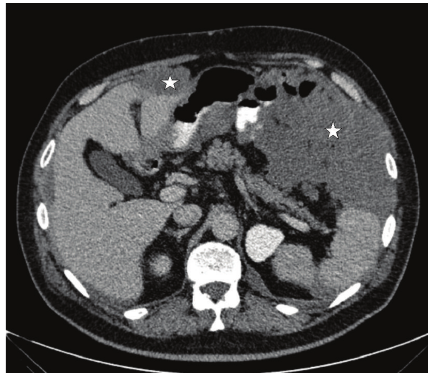
Figure 3: This CECT image shows metastatic implantations (stars) disseminated across serosal surfaces in the intraperitoneal area.